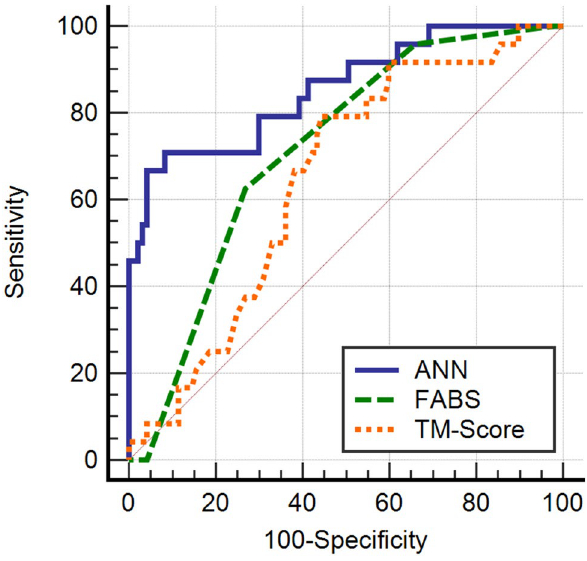
Figure 5. Comparison of MLP model, FABS, and TM-Score. AUC of the MLP model was significantly higher than that of FABS (0.855 vs. 0.715, P = 0.0038) and TM-Score (0.855 vs. 0.646, P =